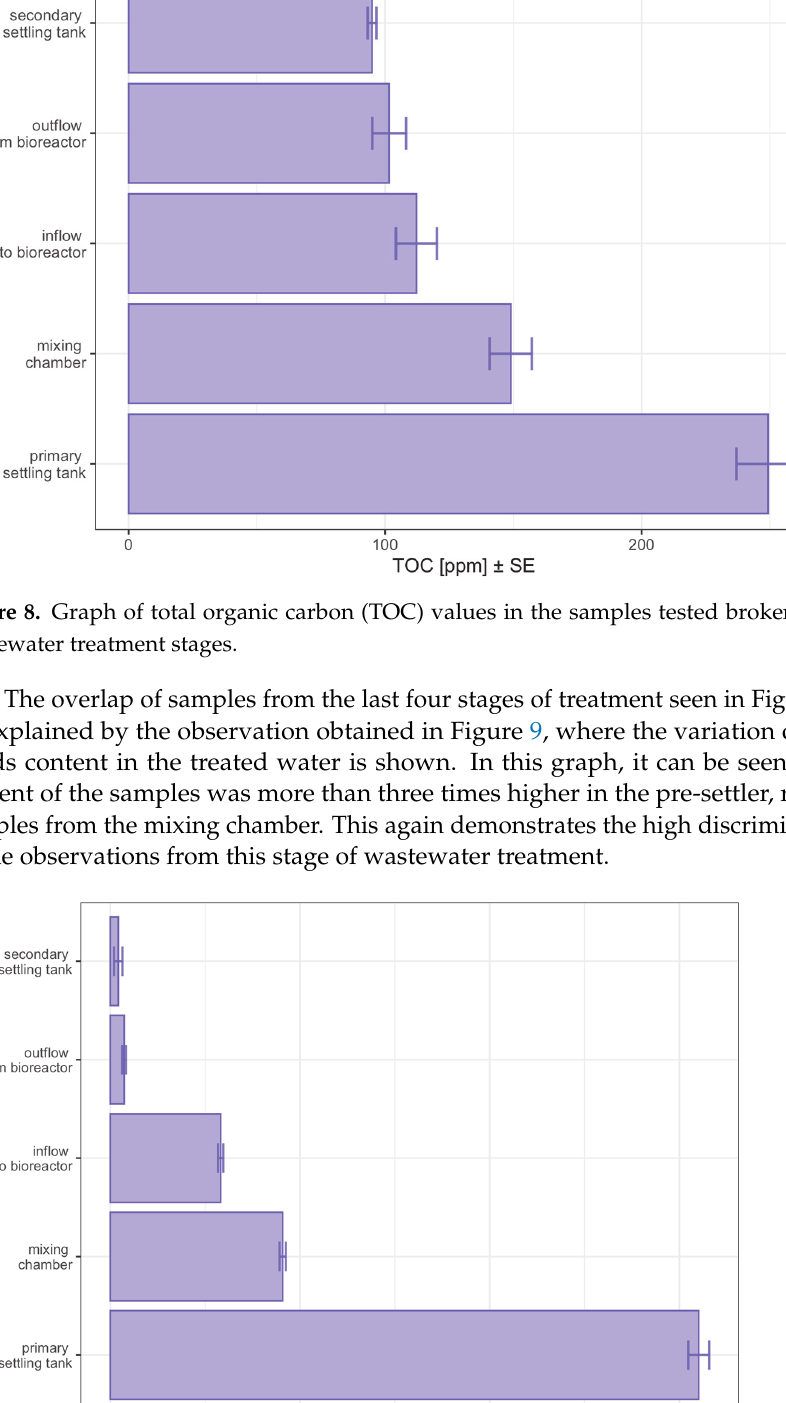
the wastewater treatment stages.